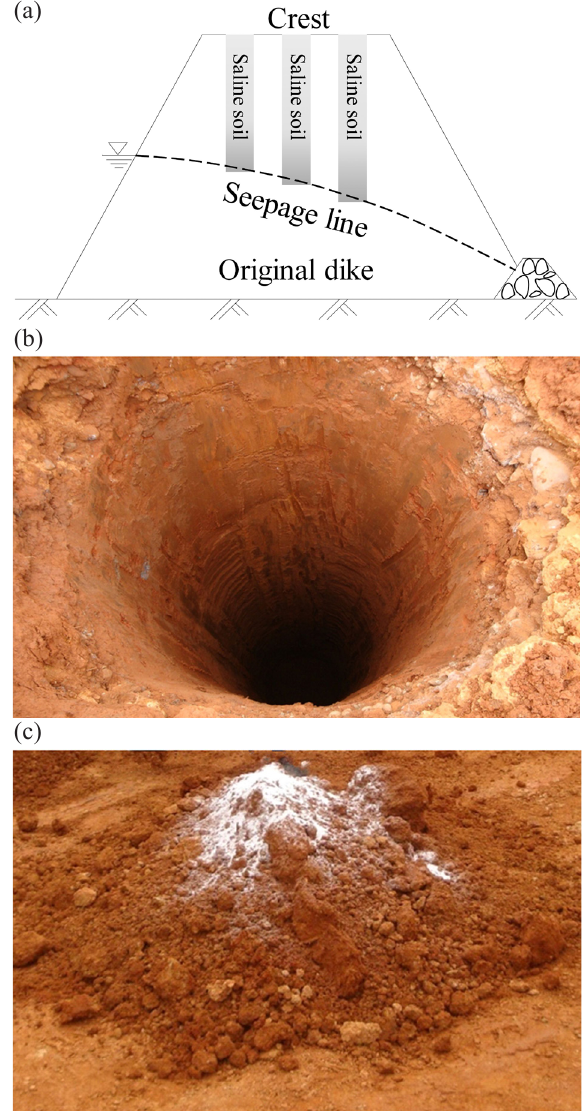
Fig 5. Site operation of termite control with saline soil. (a) Sketch diagram; (b) Dig wells; (c) Backfill with salt mixed